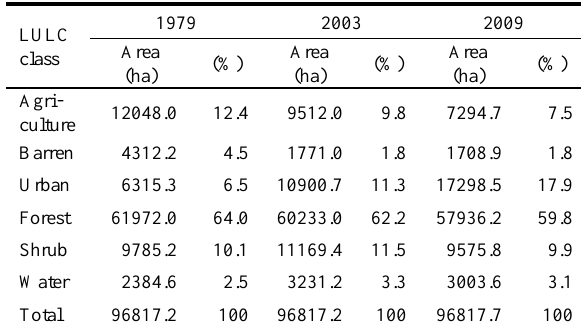
Table 3. Results of and use/cover classification for 1979, 2003 and 2009